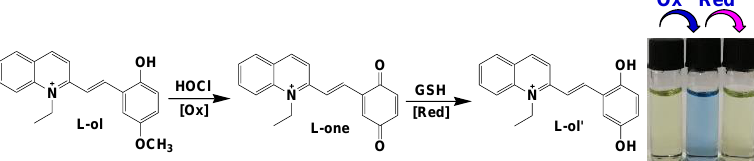
Scheme 1. The redox-switchable behaviors of L-ol regulated by hypochlorous acid (HOCl) and glutathione (GSH).